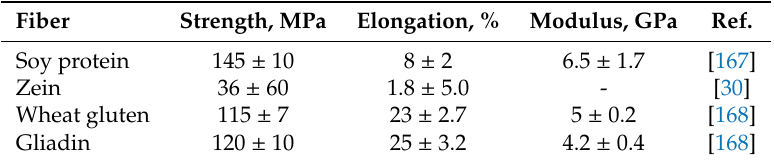
Table 4. Comparison of mechanical properties of soy protein fibers with other non-crosslinked plant protein